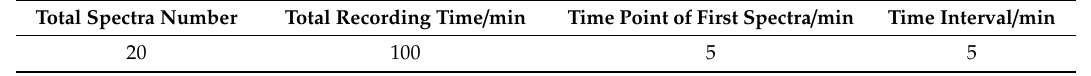
Table 2. The time intervals of the Raman spectra shown in Figure